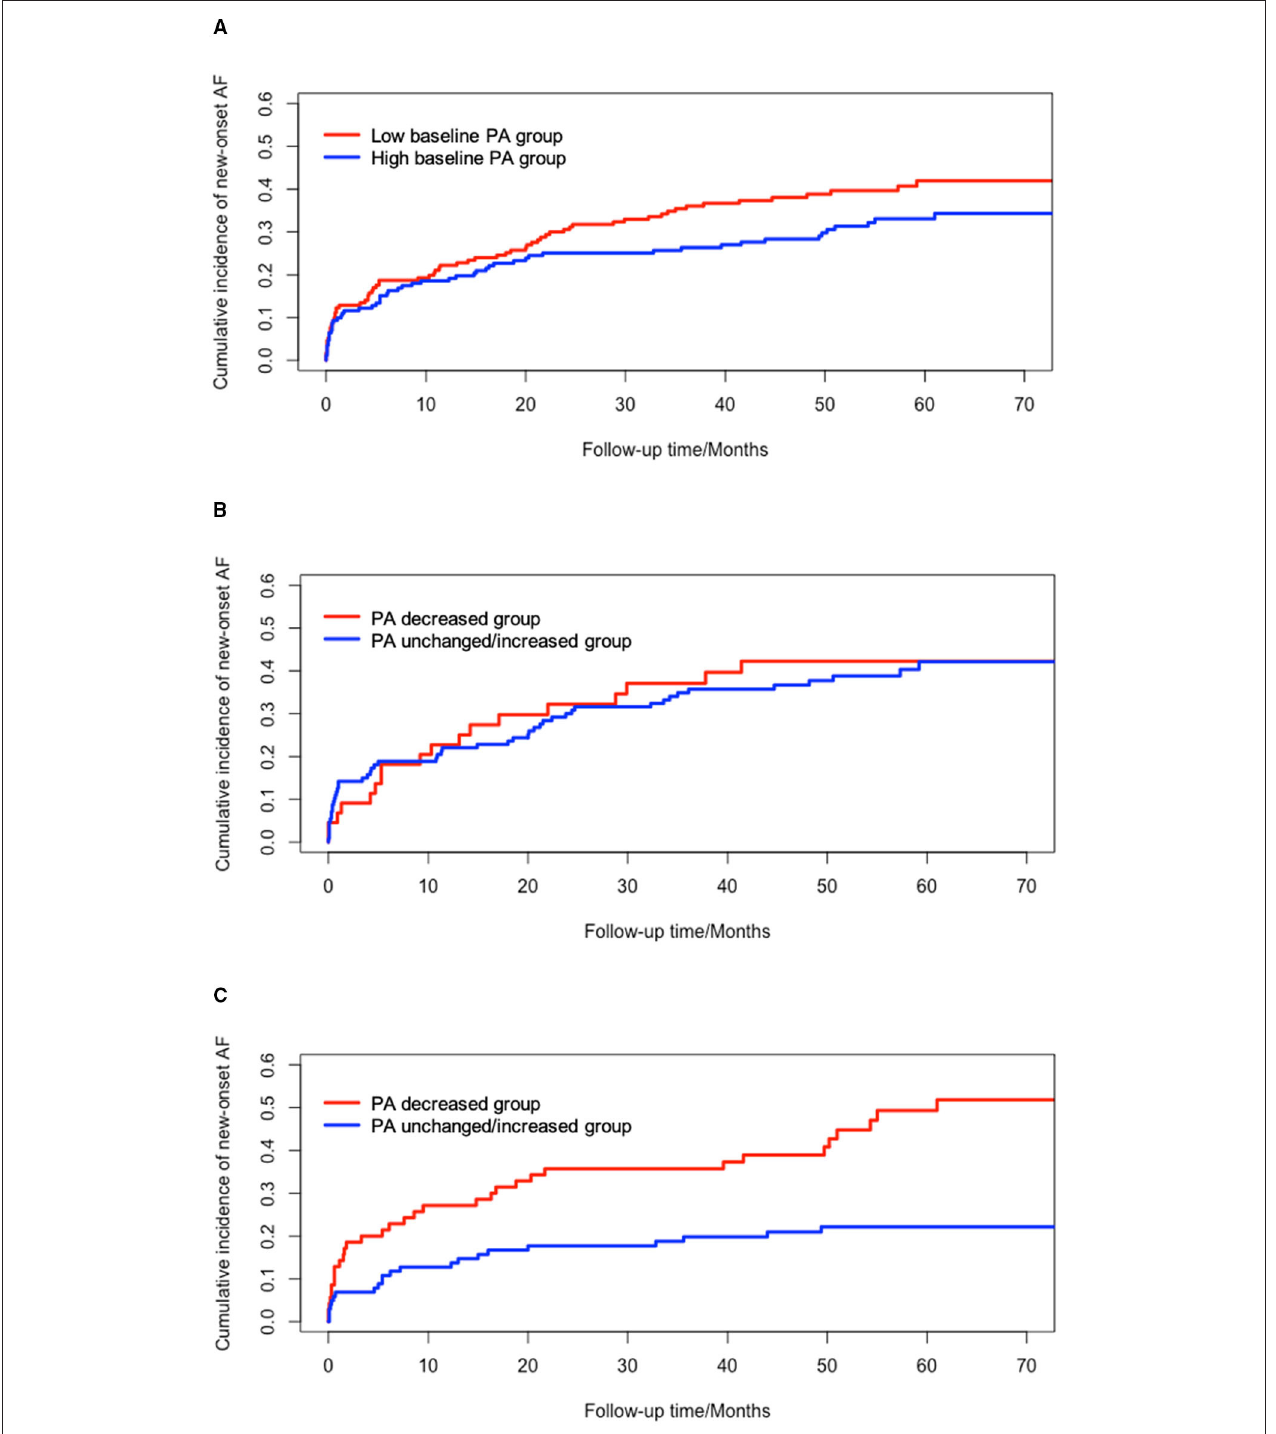
FIGURE 3 | Univariate survival analysis of new-onset AF based on different levels of PA at baseline. (A) cumulative incidence of new-onset AF between low baseline PA and high baseline PA group ( P = 0.117); (B) cumulative incidence of new-onset AF in low baseline PA group ( P = 0.761); (C) cumulative incidence of new-onset AF in high baseline PA group (Log-rank, P < 0.001). AF, atrial fibrillation; PA, physical activity.